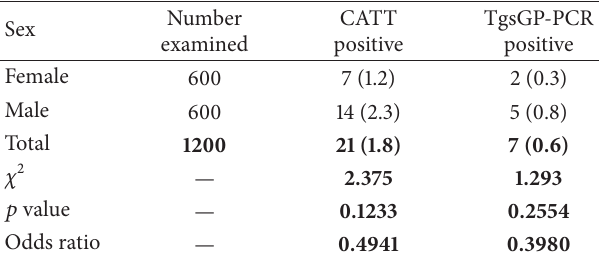
Table 2: PCR and CATT based infection rates of Trypanosoma brucei gambiense in relation to sex.